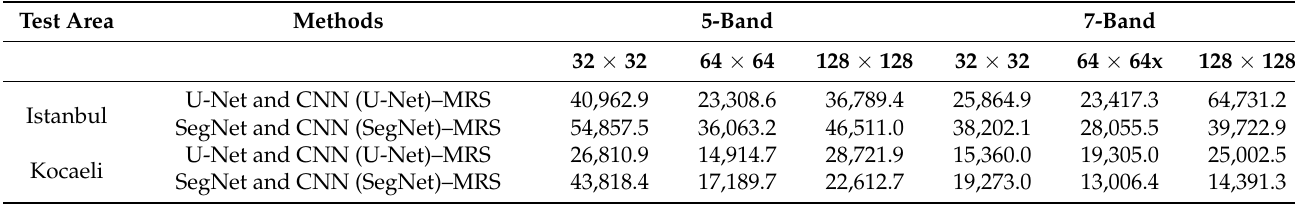
Table 14. McNemar test results for models.